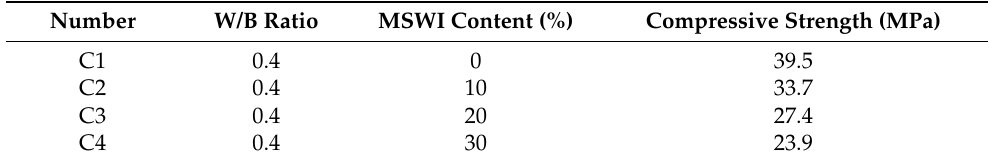
Table 7. Compressive strength of MSWI recycled